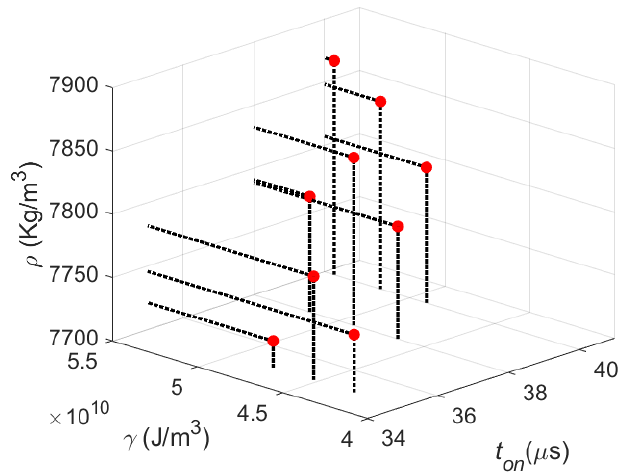
Figure 4. Graph of the resulting bulk density (ρ) with respect to exposure time ( t on ) and volumetric energy density (γ). In general, it is observed that higher bulk density values are attained at higher exposure time and volumetric energy density conditions. Please notice that the volumetric energy density (γ) values, in J/m 3 , are in the ×10 10 range.